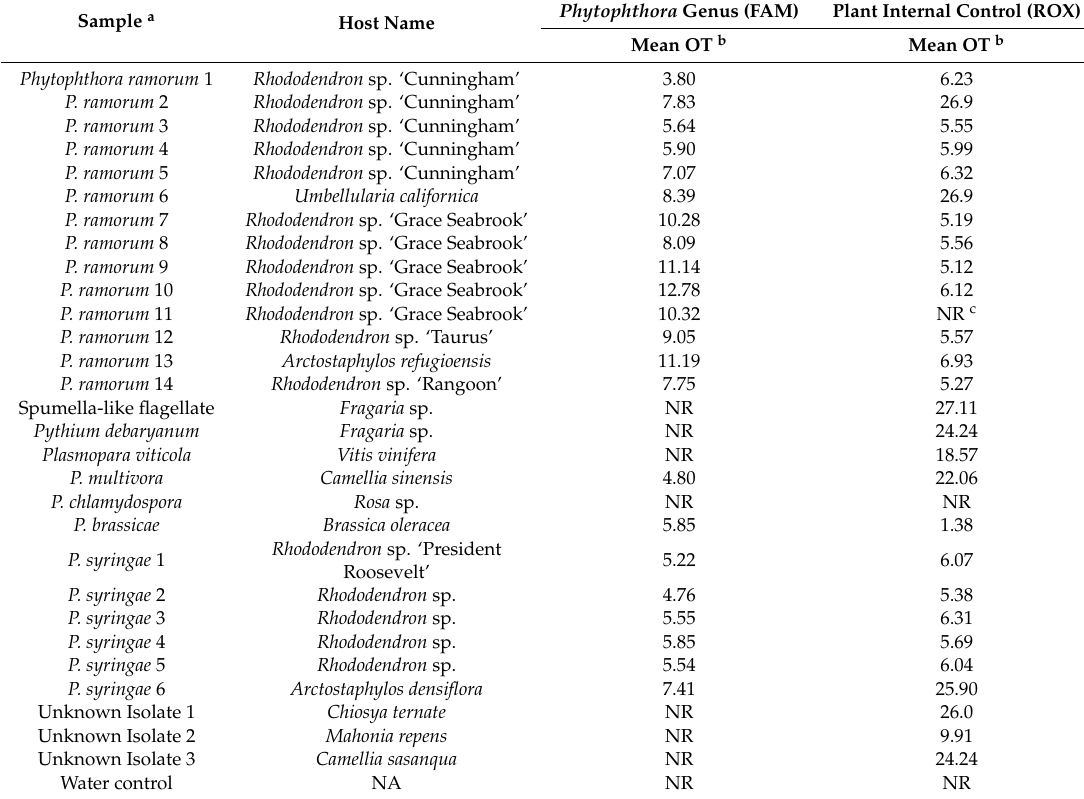
control. * n = 1. Table 5. Environmental samples tested with the preformulated RPA assay on the QuantStudio 6 platform. Sample a Phytophthora ramorum